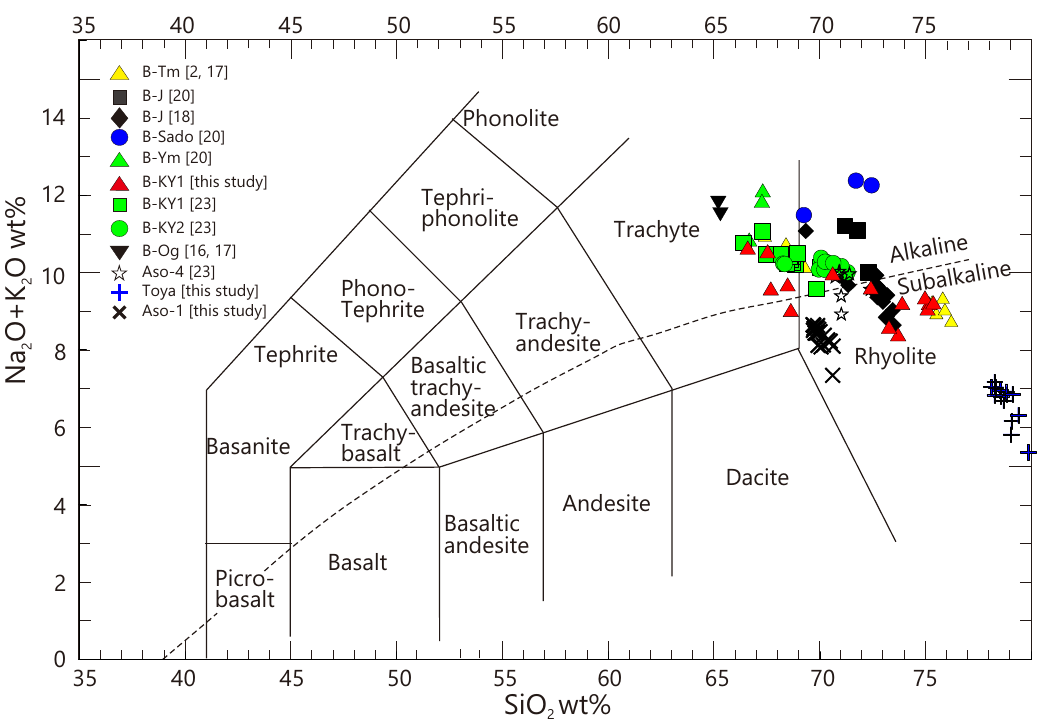
Figure 6. Total alkali versus silica (TAS) diagram (Classification diagram adapted from [42]) of Baekdusan tephra samples and other Japanese tephra samples from ODP 794A core (Data from